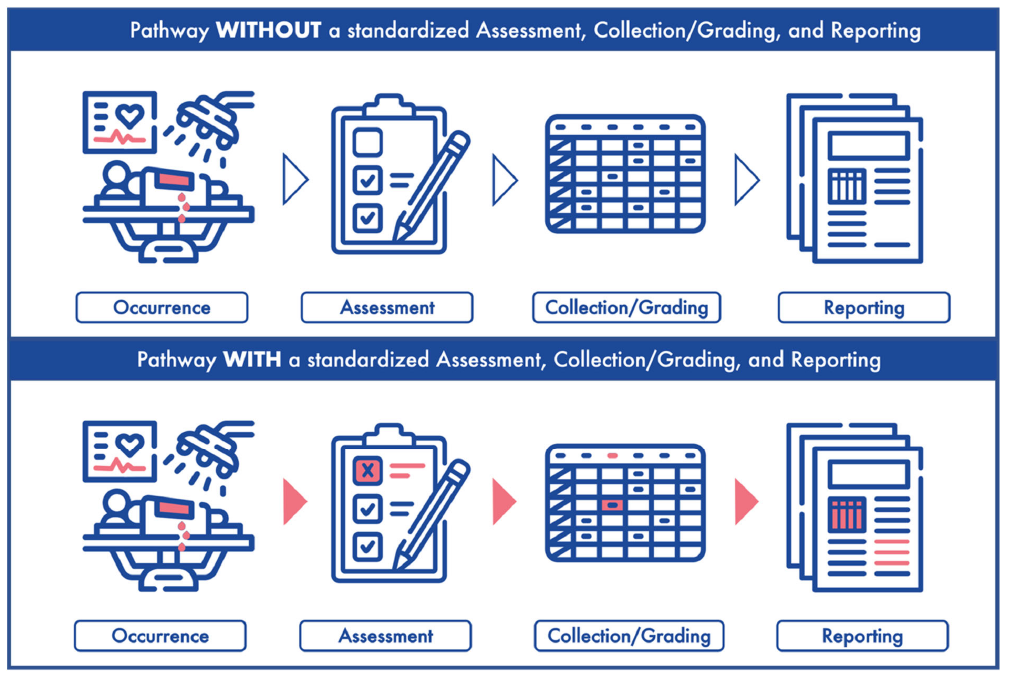
Figure 1. The long road from occurrence to reporting. ( Upper panel ) depicts an adverse event occurrence, assessment, collection/grading and reporting without a standardized system. ( Lower panel ) represents an adverse event occurrence, assessment, collection/grading and reporting with a standardized system.